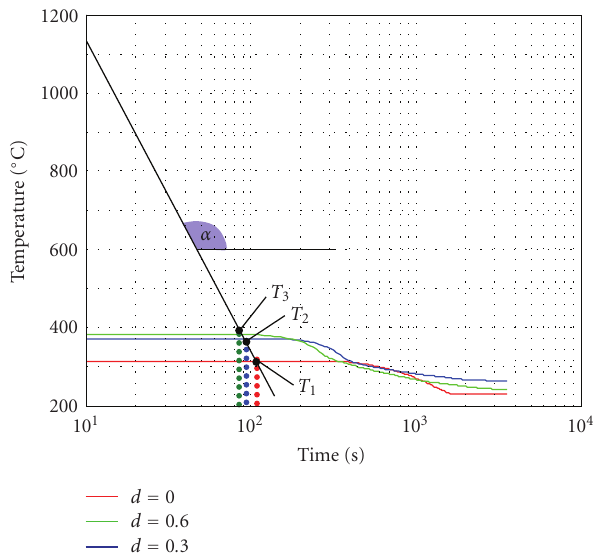
Figure 5: Scheme of data transformation into the ( α , time ) coordinate